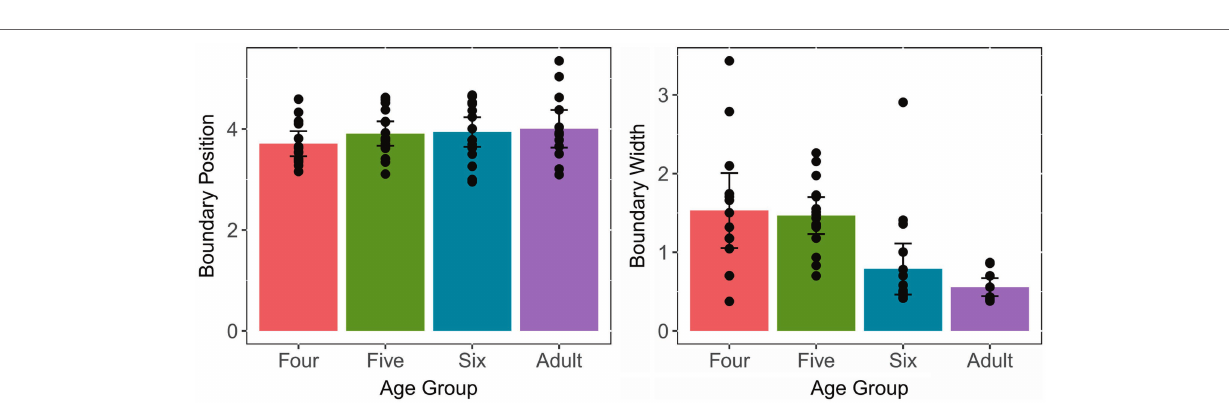
FIGURE 4 | Means and standard errors of the boundary position and width for the Tone 1-2 continuum across age groups. Error bars: ±1 standard